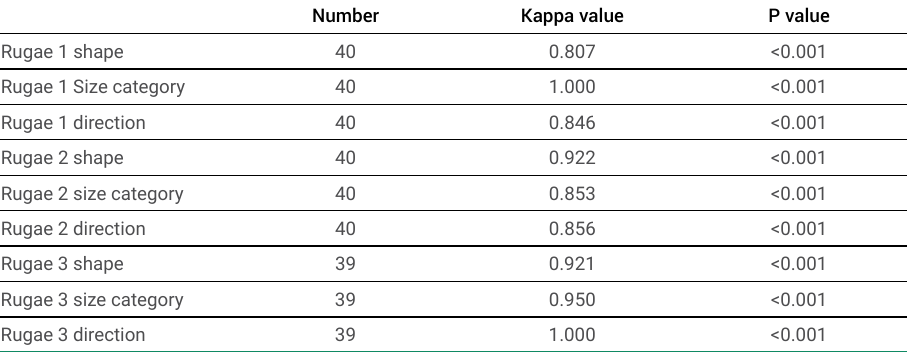
Table 1. Validity of 3D digital palatal rugae measurements.